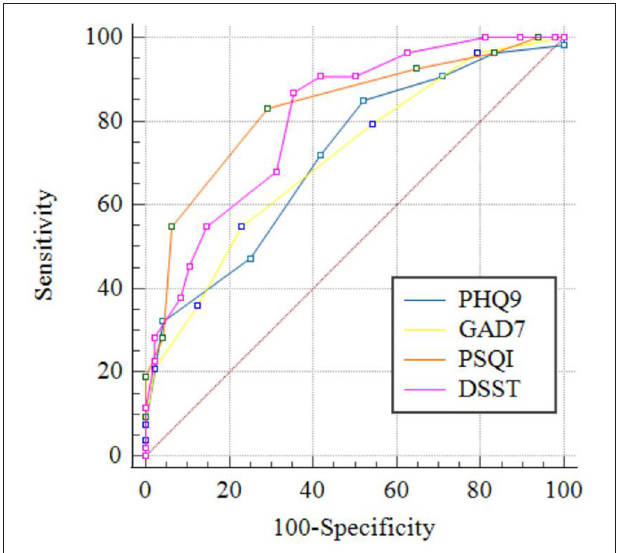
FIGURE 3 | ROC curves of the clinical data in predicting the therapeutic